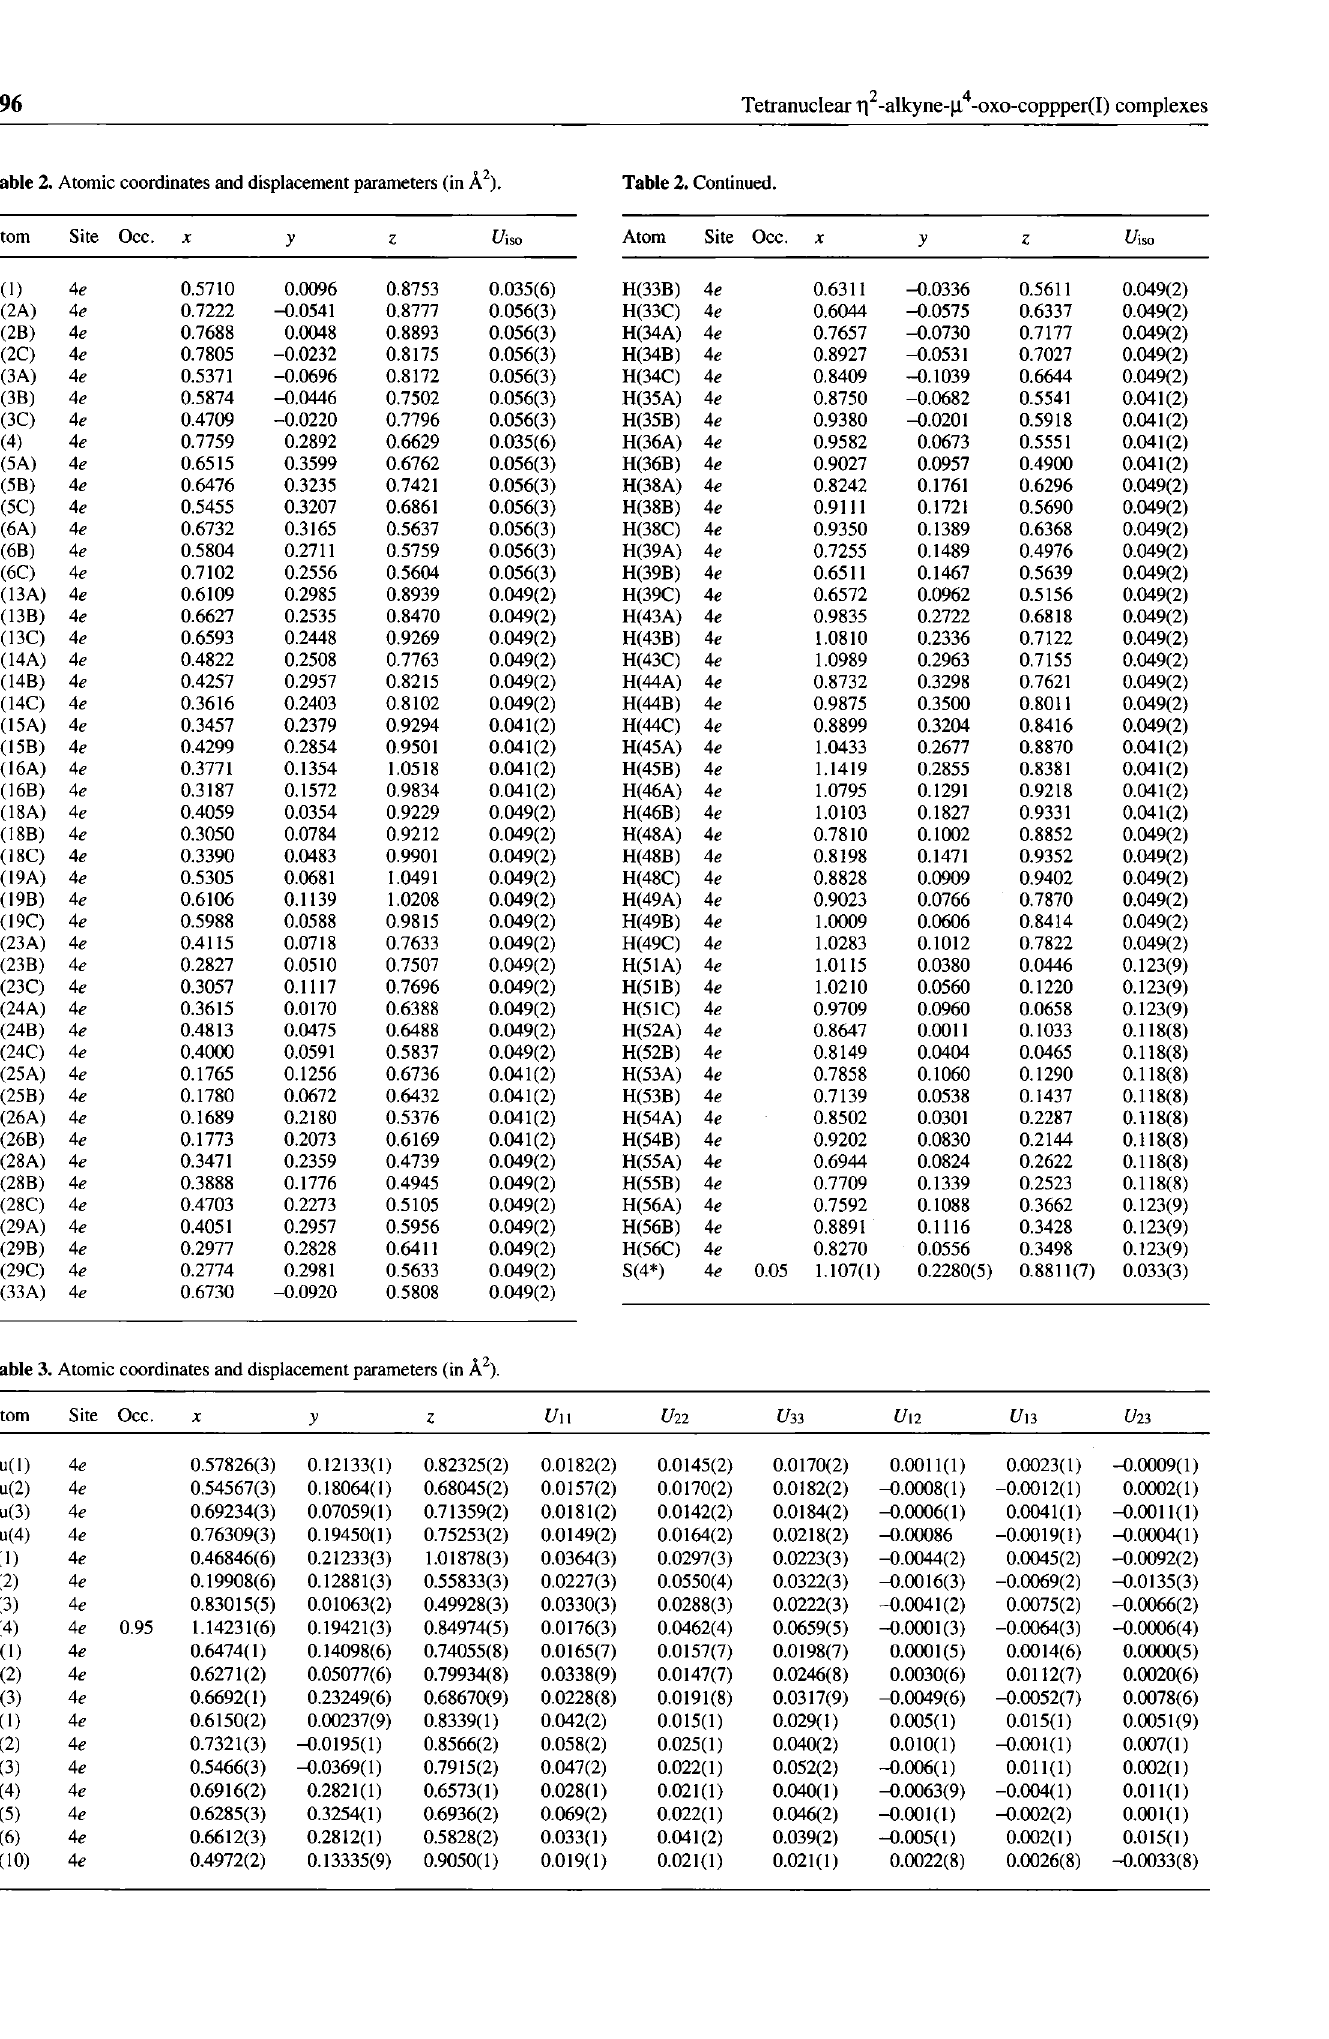
Table 2. Atomic coordinates and displacement parameters (in A 2 ). Table 2. Continued.